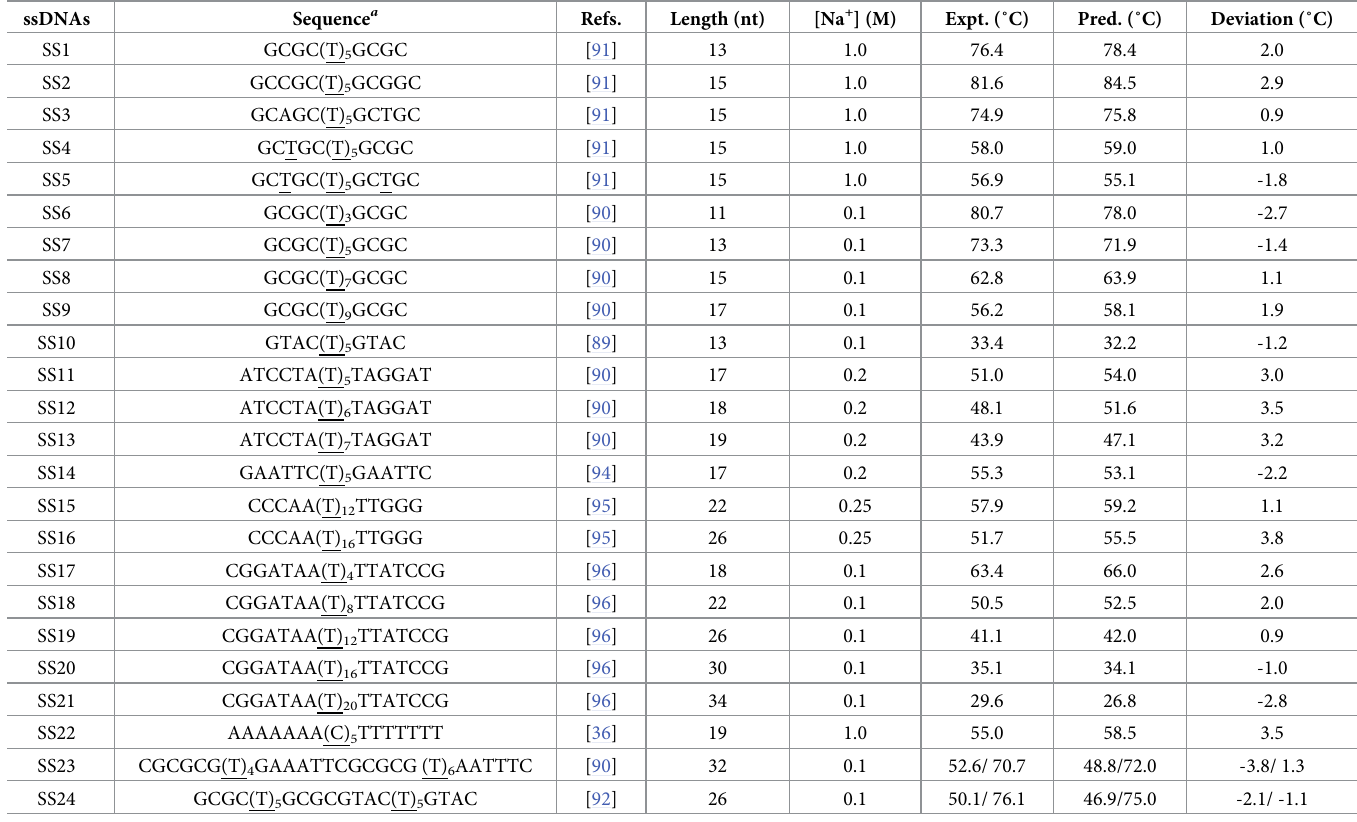
Table 2. The melting temperatures ( T m ) for single-stranded DNAs at given ion conditions. ssDNAs Sequence a